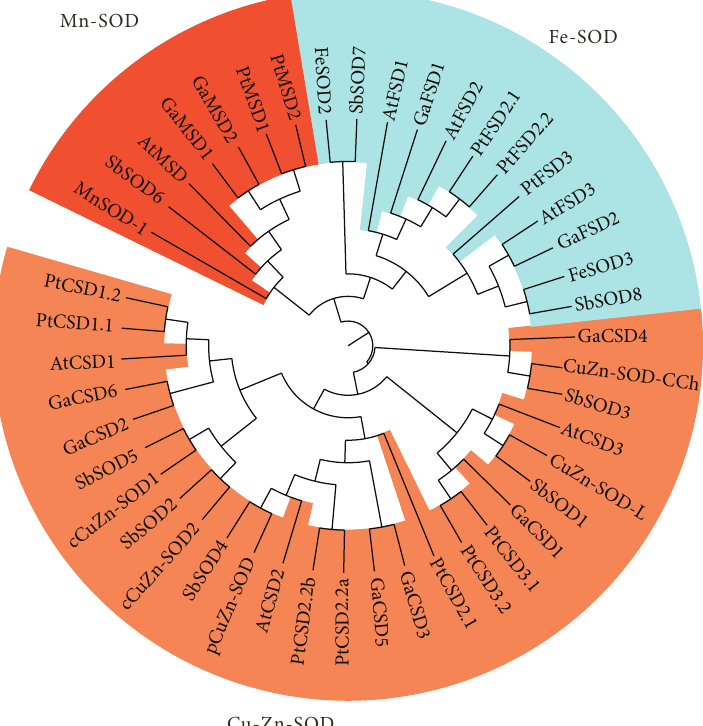
Figure 1: Phylogenetic relationships of SOD gene from G. arboreum , G. raimondii , Arabidopsis , rice, populus, and Sorghum . The three subfamilies are indicated with different colors. The CaSODs represent the 10 SOD genes in G. arboreum , GrSODs represent the 10 SOD gene in G. raimondii , the AtSODs represent the 7 SOD genes in Arabidopsis , PtSODs represent the 12 SOD genes in polar, Cu-Zn-SOD genes represent the 8 SOD gene in rice, and SbSODs represent the 8 SOD genes in Sorghum